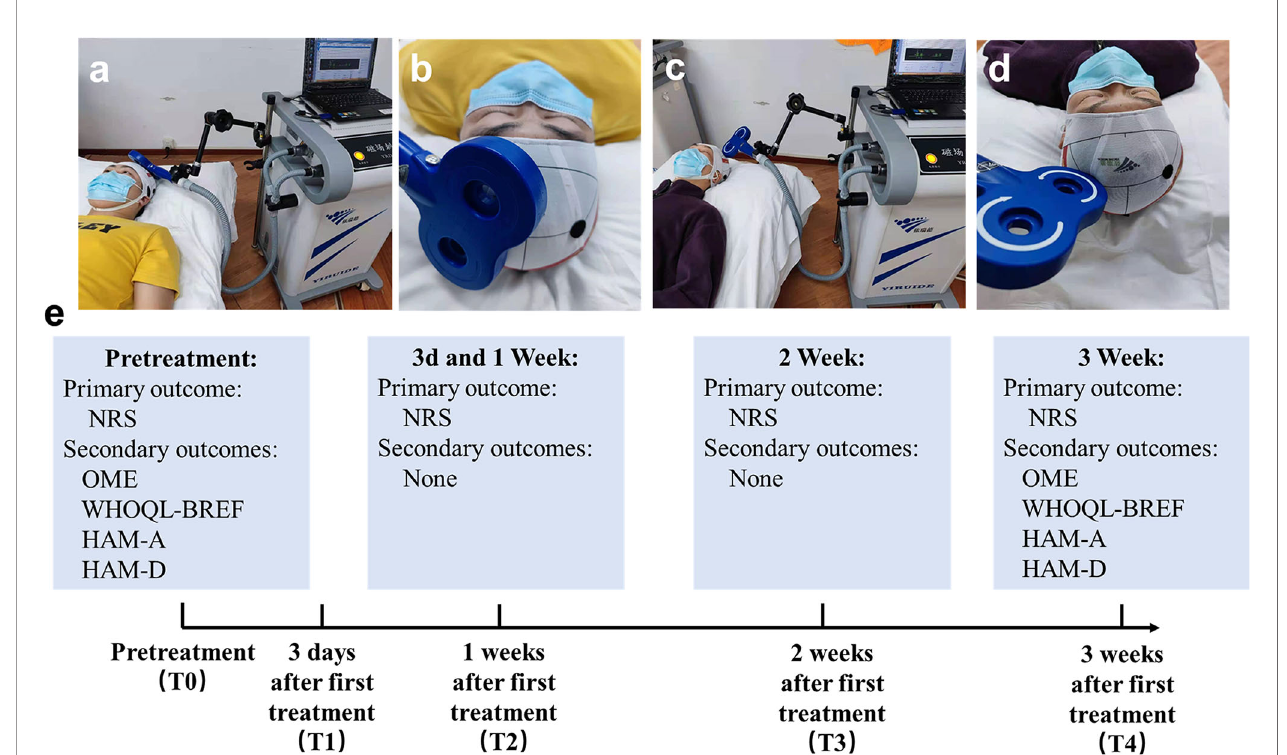
FIGURE 1 | Schematic diagram of the experimental design. (A) Image of the treatment in rTMS group, (B) Close-up of the coil in rTMS group. (C) Image of the treatment in sham group, (D) Close-up of the coil in sham group, (E) Primary and secondary outcomes at different time